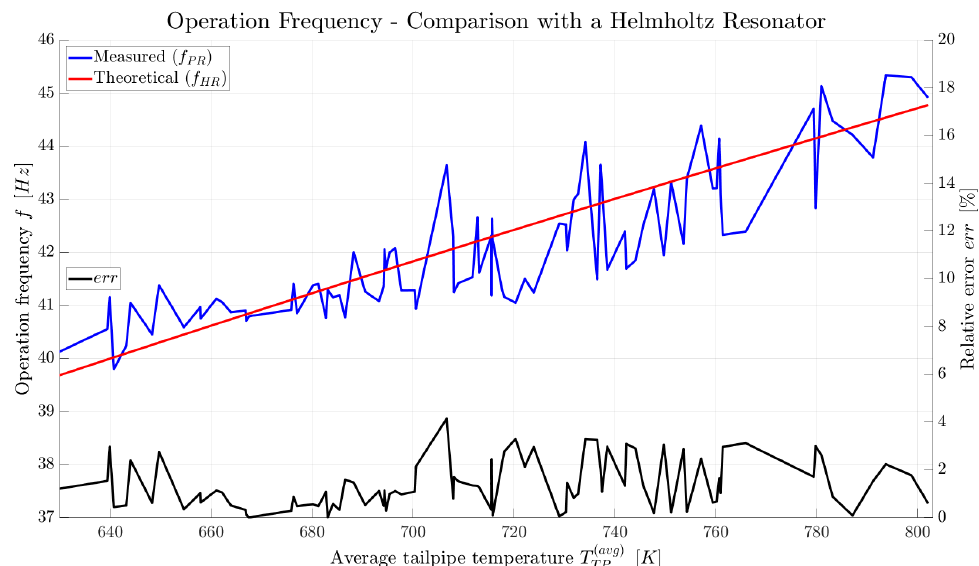
Figure 10. Measured PR operation frequency ( f PR ) compared with the theoretical frequency of a Helmholtz resonator ( f HR ) calculated using relation (1).